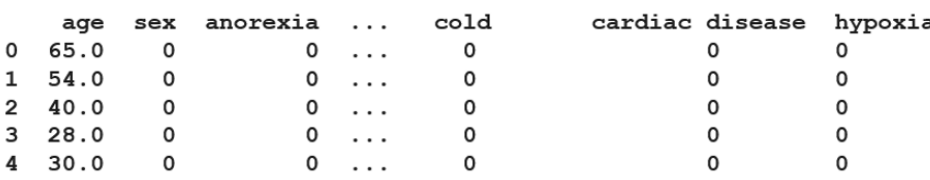
Figure 3. Sample of the original clinical dataset in tabular rows.